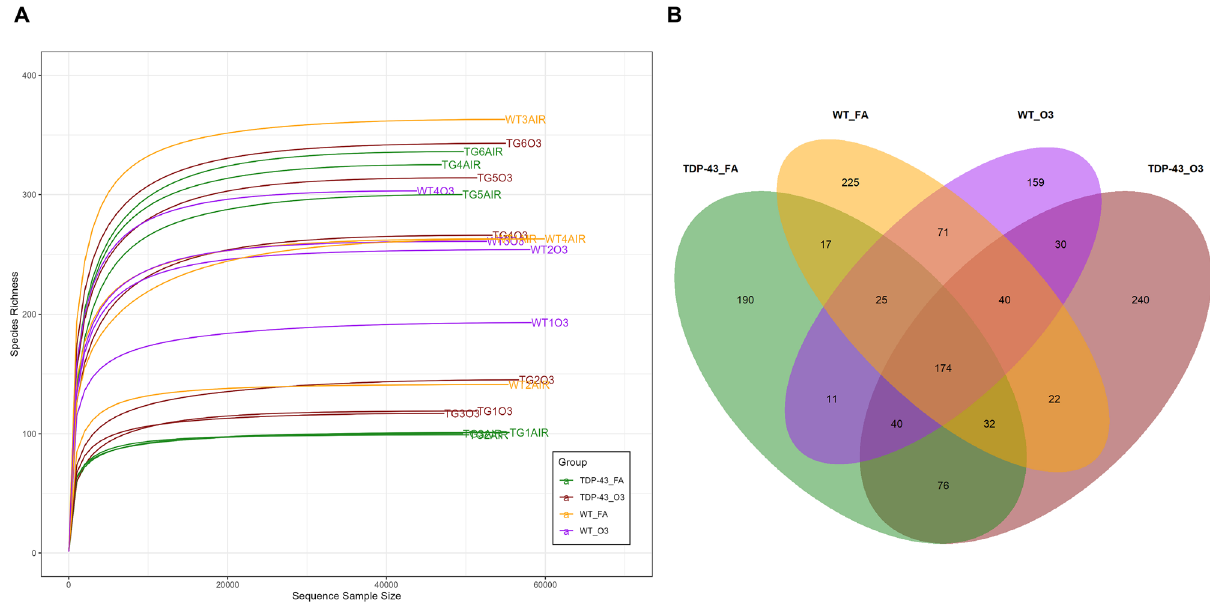
Figure 5. WT controls and TDP-43 A315T mice fecal microbiota diversity. ( A ) Rarefaction curves for the samples analysed within the four groups (TDP-43-FA, TDP-43-O 3 , WT-FA and WT-O 3 ). ( B ) Venn diagram of four groups (TDP-43-FA, TDP-43-O 3 , WT-FA and WT-O 3 ) and their intersections. The numbers correspond to the number of ASVs in each subset and intersection. Abbreviations: WT, Wild-type mice; TDP-43 , TDP-43 A315T mice; FA, filtered air; O 3 ,